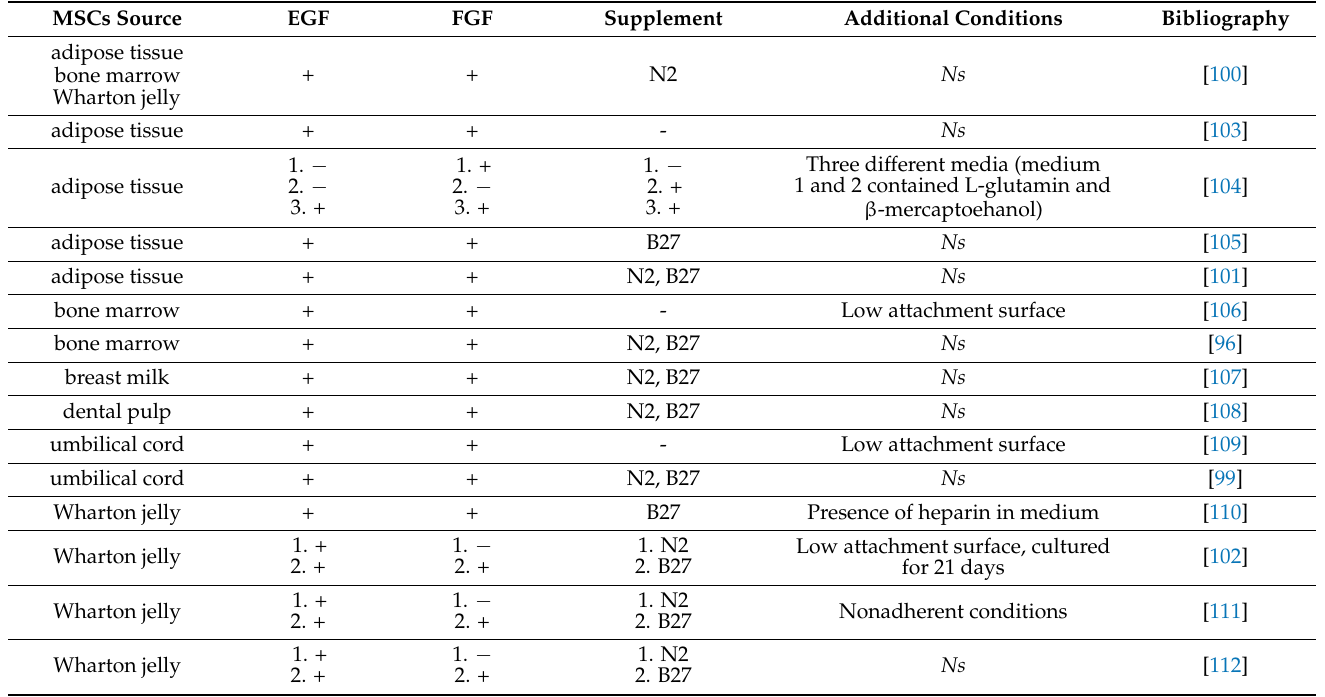
Table 2. Methods of forming MSC